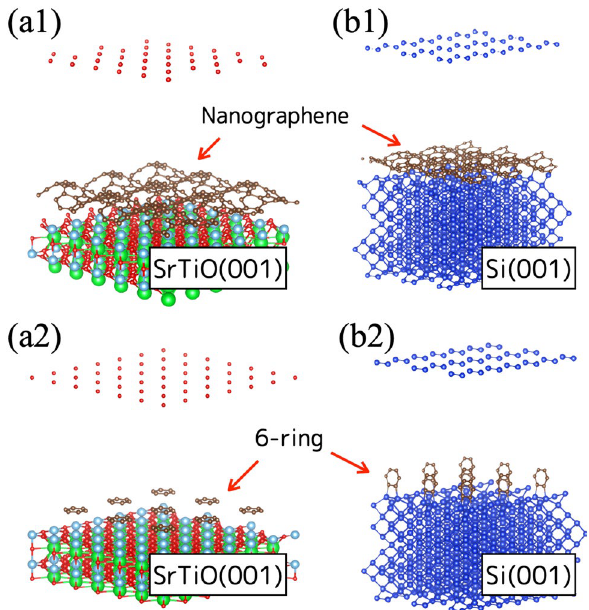
Figure 3. Structure of supercell after optimization. Nano graphene was placed flatly on ( a1 ) SrTiO 3 (001) and ( b1 ) Si(001) substrates. 6-ring was also placed on ( a2 ) SrTiO 3 (001) and ( b2 ) Si(001) substrates. The 6-ring stood up vertically on Si surface after optimization while 6-ring flatly lied on SrTiO 3